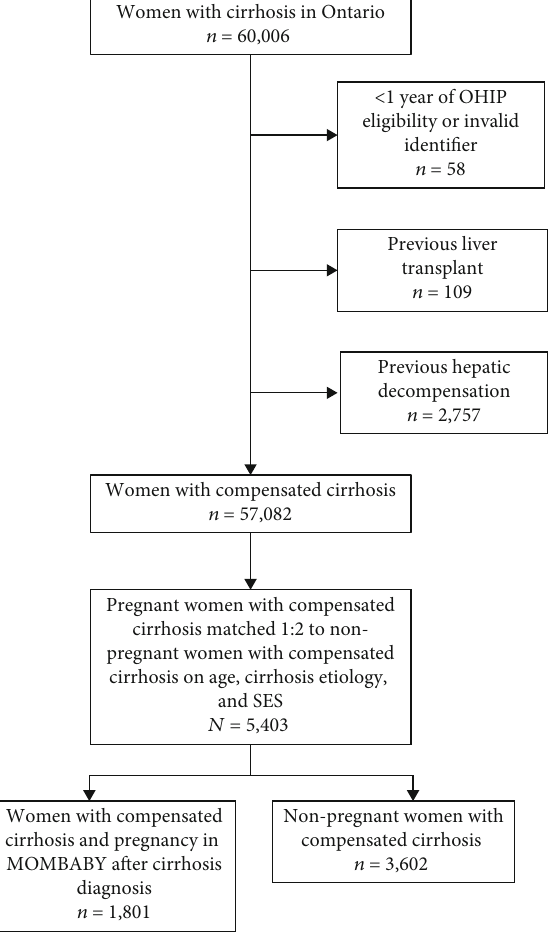
Figure 1: Inclusion and exclusion criteria for creation of cohort of pregnant women with cirrhosis matched 1 :2 to nonpregnant women with